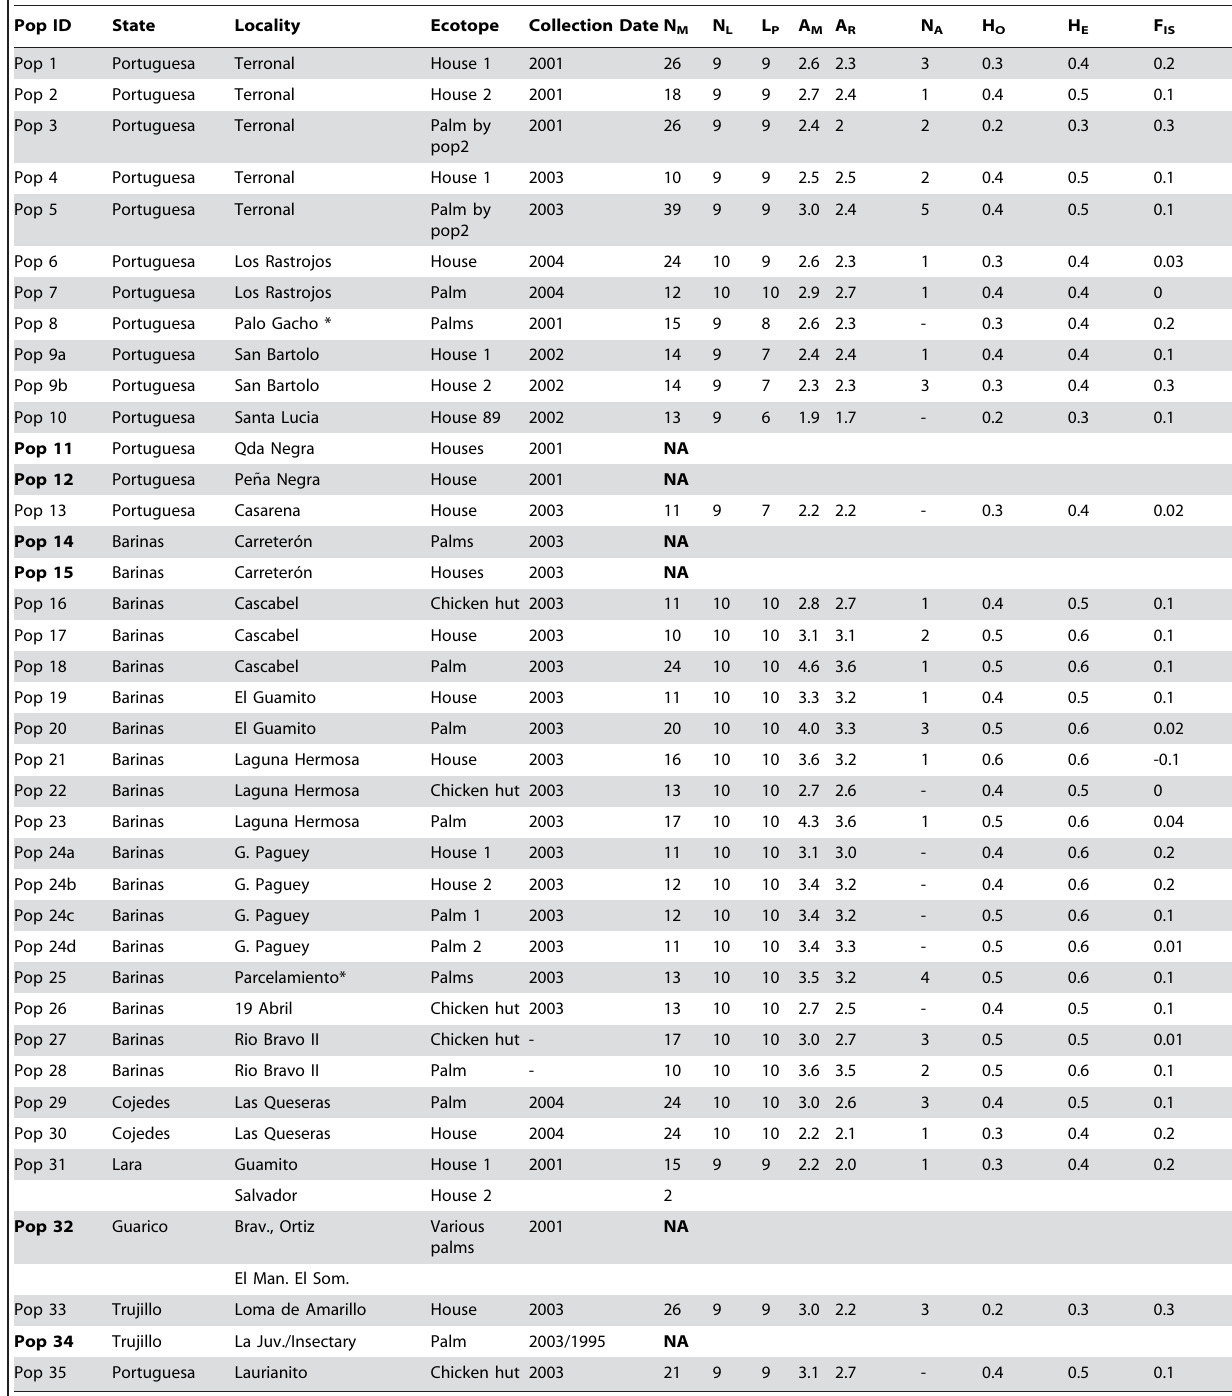
Table 2. Details of the 33 populations analysed by